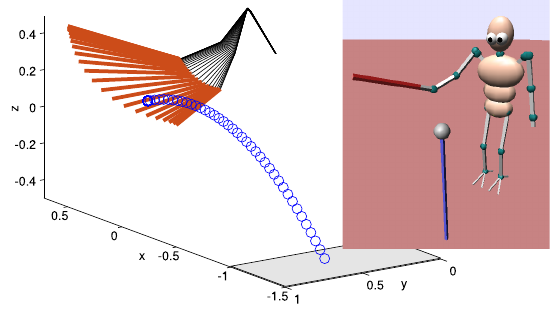
Figure 2. The T-ball task for the CBi robot. The bat and ball trajectory are those as learned after 20 updates.